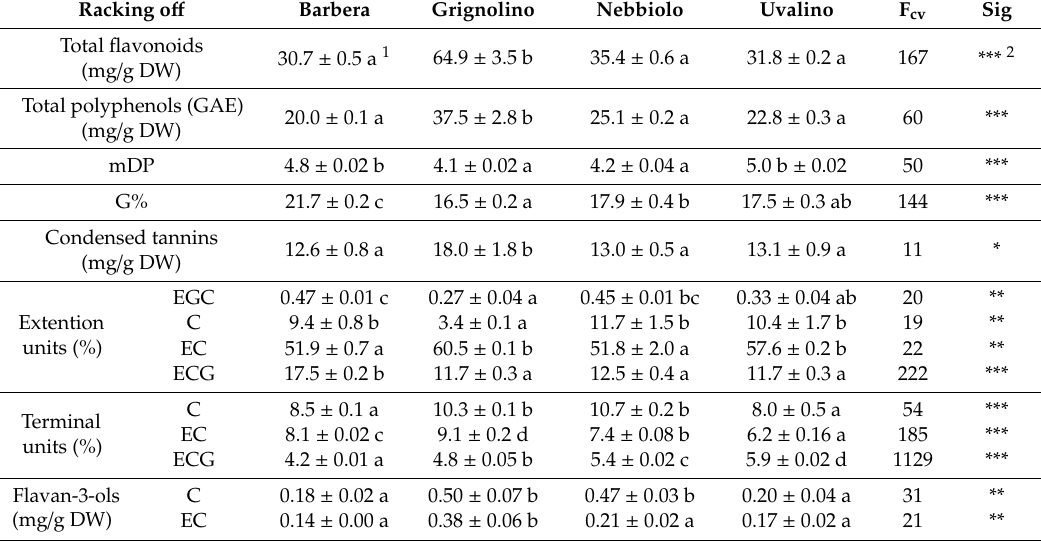
Table 2. Polyphenolic composition of the grape seeds sampled from the fermented pomace after racking o ff . ANOVA and Tukey’s test results. mDP = mean degree of polymerization; G% = percentage of galloylation; EGC = ( − )-epigallocatechin; C = ( + )-catechin; EC = ( − )-epicatechin; ECG = ( − )-epicatechin-3- O